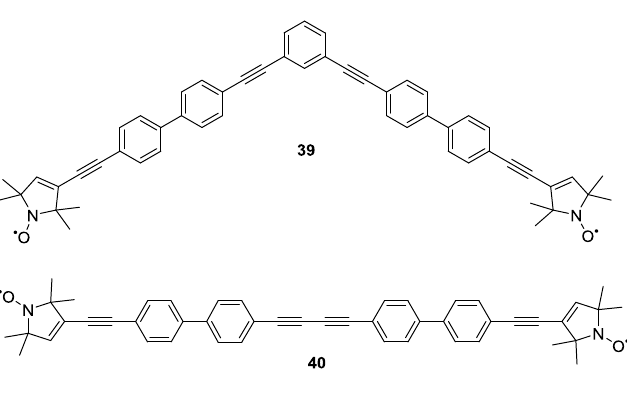
Figure 6. One linear and bent